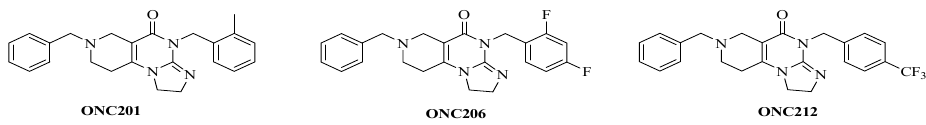
Figure 1. Reference imipridones with numbering of the substituted skeletal nitrogen